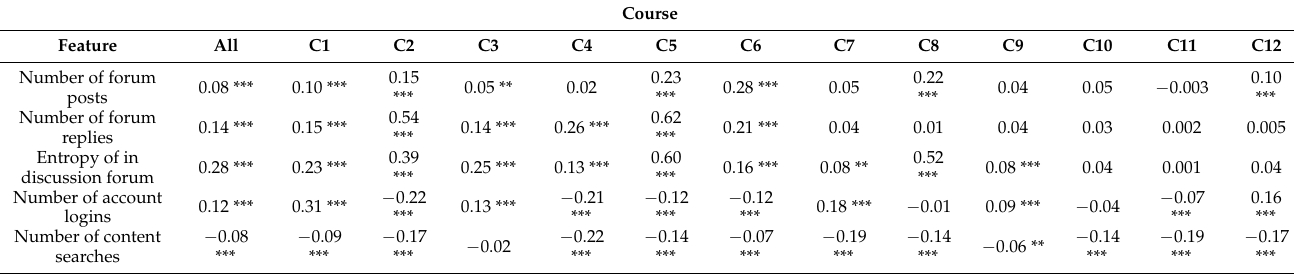
Table 3. Pearson correlation coefficient of all course